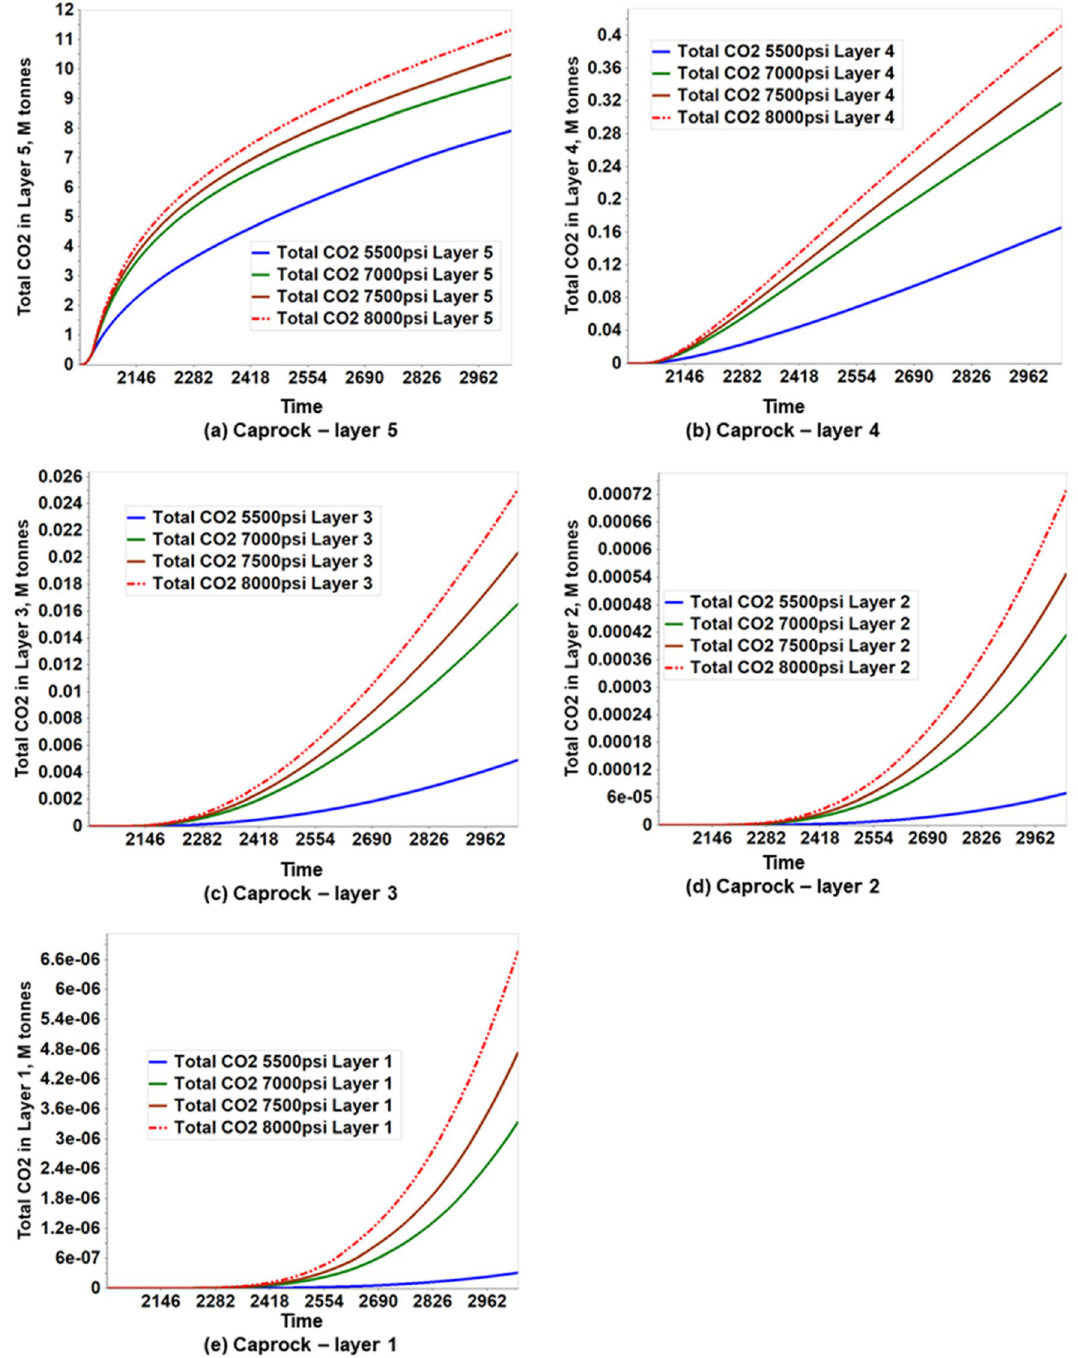
Figure 20. Amount of CO 2 accumulated in the caprock layers resulting from pressure sensitivity